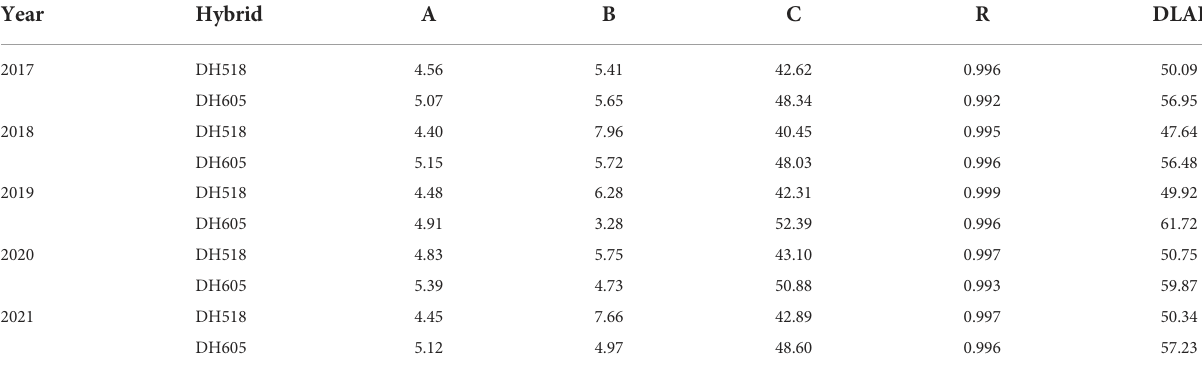
TABLE 7 Characteristic parameters of LAI fi xt by Gaussian Model of summer maize hybrids with different growth duration from 2017 to